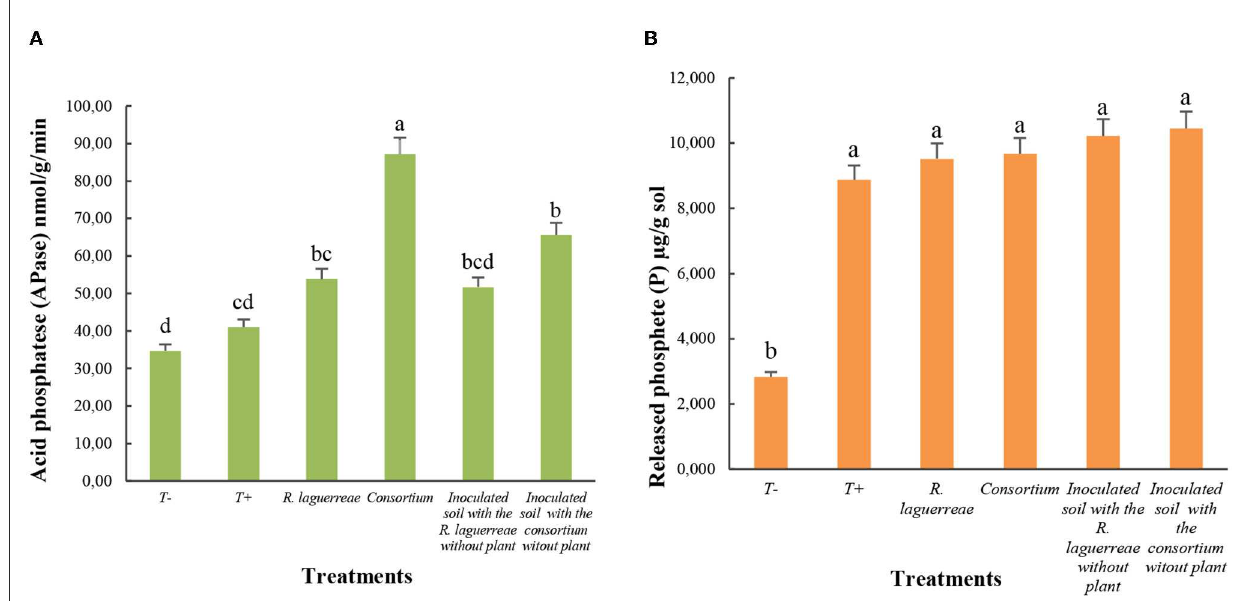
FIGURE11 Available P (A) and acid phosphatase activity (B) and analysis in rhizospheric soil of plants inoculated with rhizobia alone or with the consortium. Each value represents the mean ± of three independent replicates; different letters indicate that the values by Tukey’s test are statistically different at a P -value of ≤